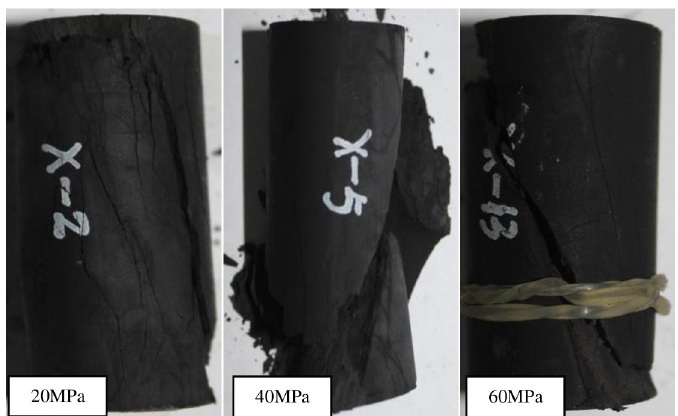
Fig 8. Fractured samples after unloading with different initial confining